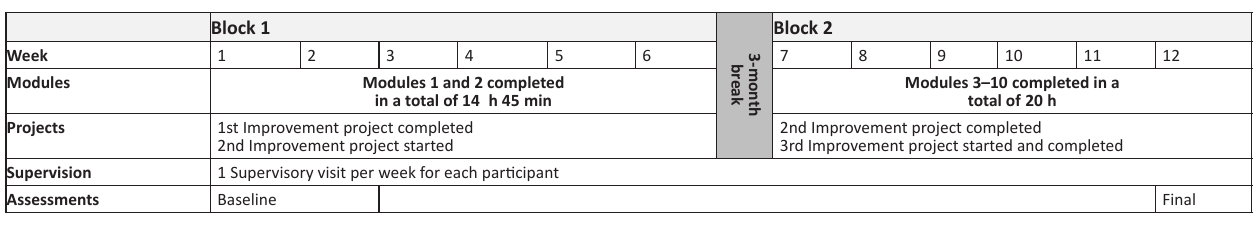
FIGURE 1: Schematic of the Strengthening Laboratory Management Towards Accreditation (SLMTA) Cohort 1 rollout.